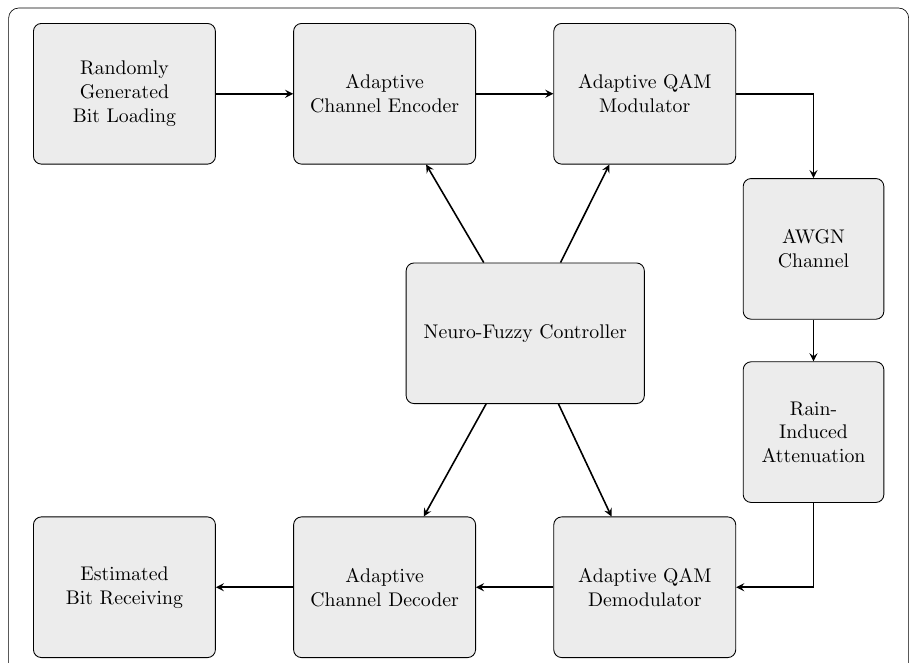
Fig. 1 Neuro-Fuzzy-based ACM block diagram. It is a pictorial representation of each step which describes each process of the Neuro-Fuzzy-based adaptive code